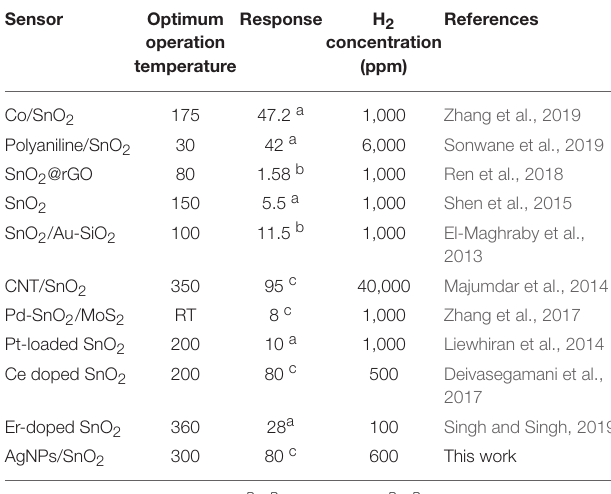
TABLE 2 | A comparison between the fabricated AgNPs/SnO 2 sensor with the different sensors reported in the literature.